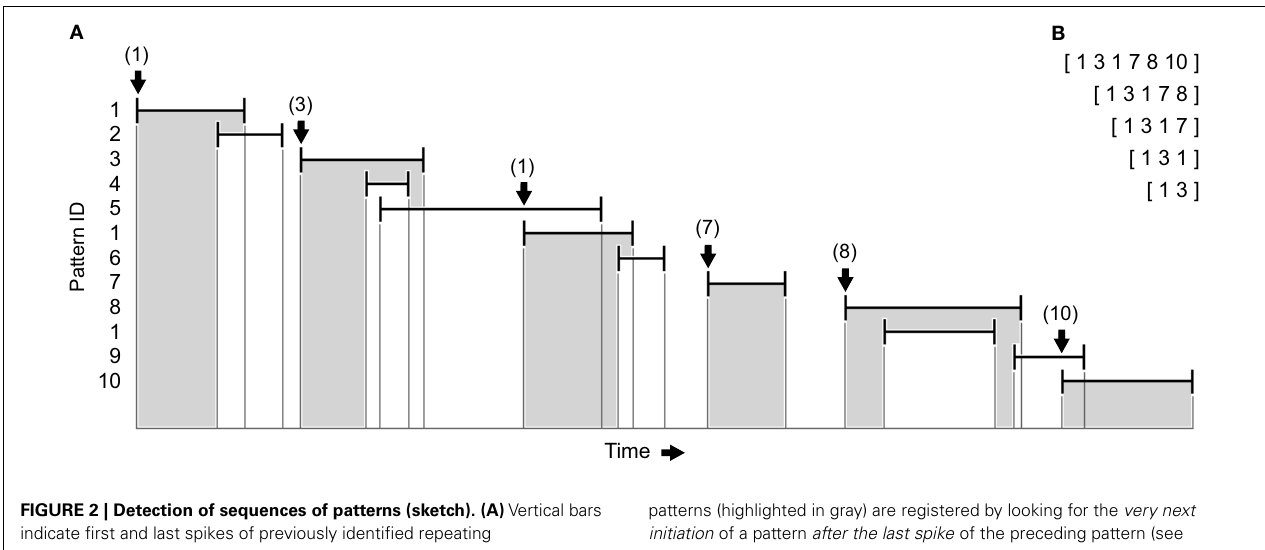
FIGURE 2 | Detection of sequences of patterns (sketch). (A) Vertical bars indicate first and last spikes of previously identified repeating spatiotemporal firing patterns, horizontal bars indicate their duration. A unique ID is assigned to every pattern, and sequences comprising an arbitrary number of temporally non-overlapping, directly consecutive